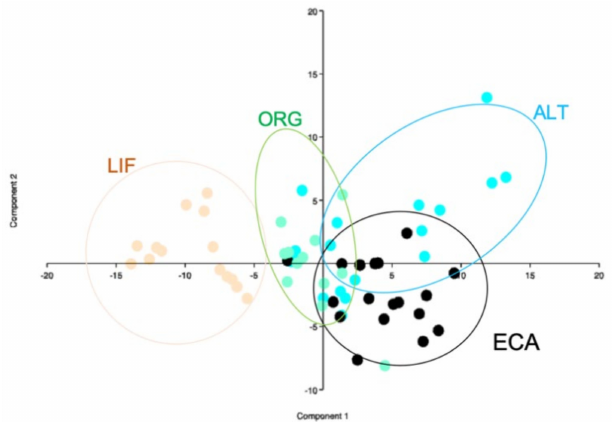
Figure 2. Principal component analysis with fatty acids profile; component 1 (horizontal axis) and 2 (vertical axis). ALT = alternative with outdoor space, ECA enriched cage, LIF = litter floor, ORG = organic. IND = only indoor, OUT = outdoor space